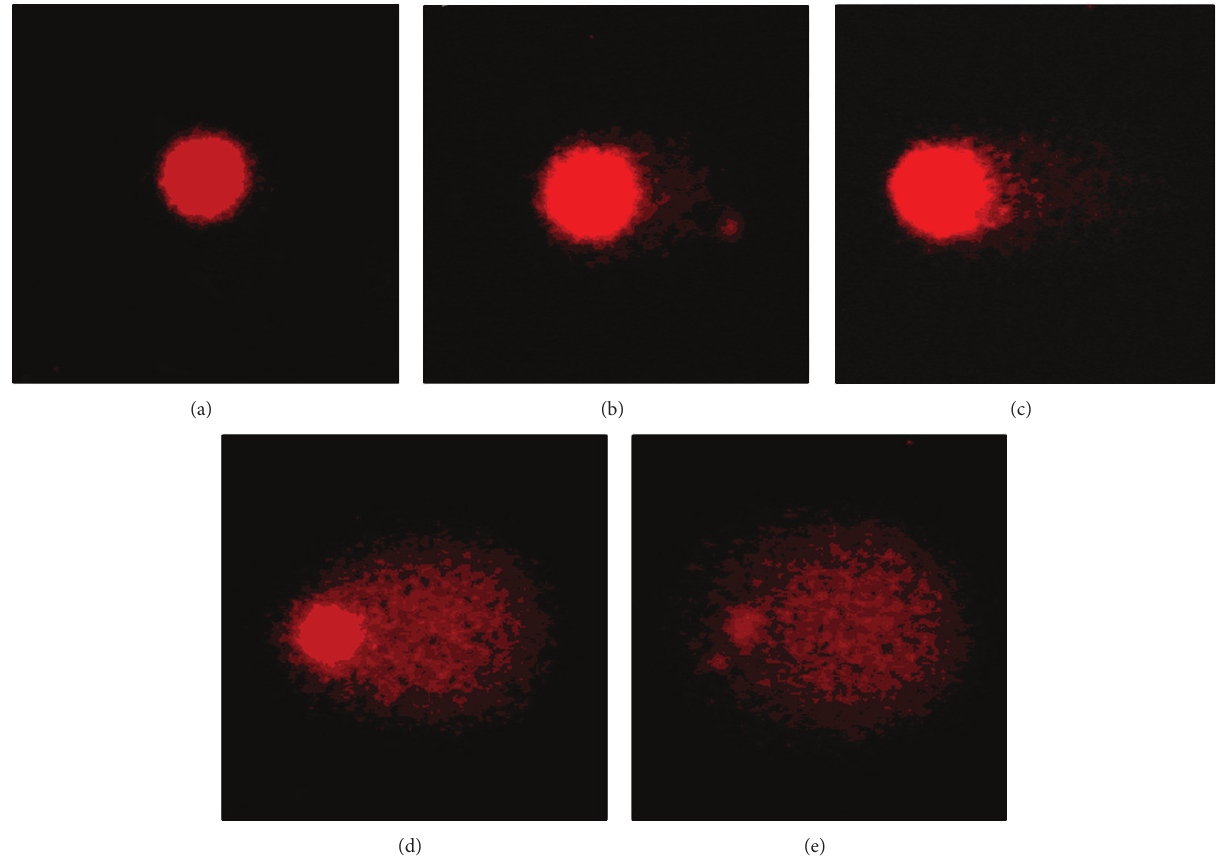
Figure 1: Categorisation of DNA damage corresponding to the amount of DNA in the